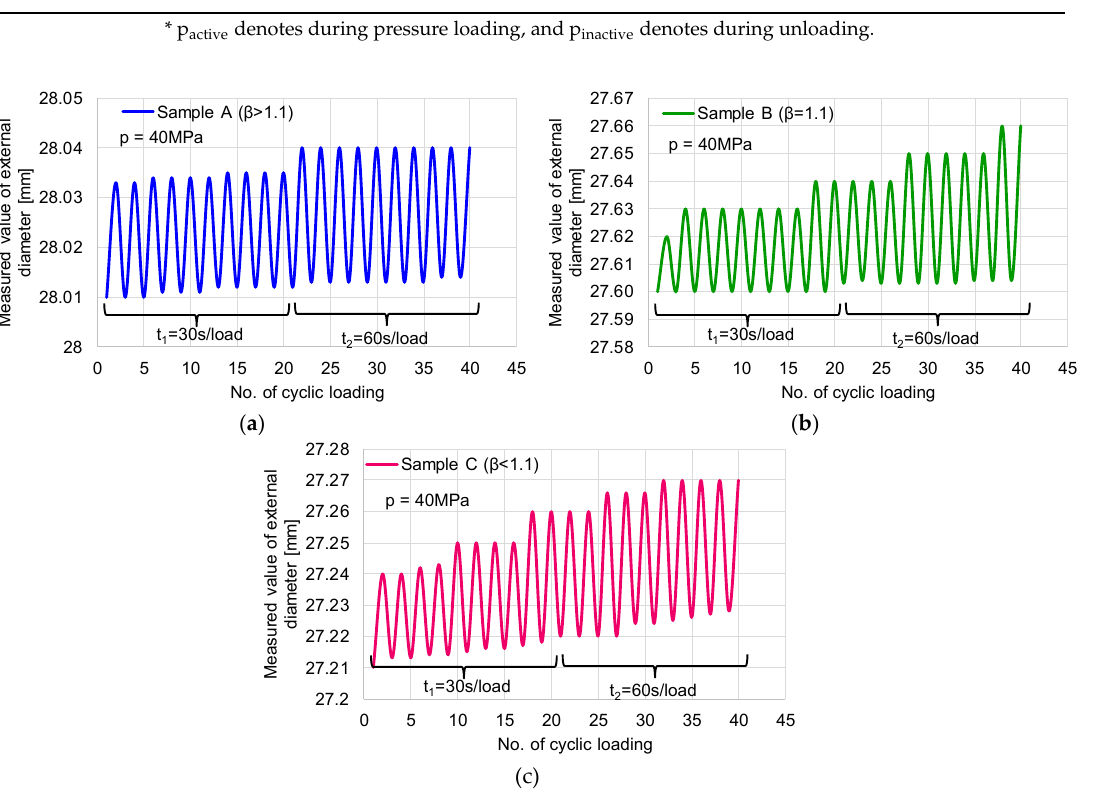
( b ) Figure 12. Variation of exterior diameter during test: ( a ) unloading cycles; ( b ) loading cycles.